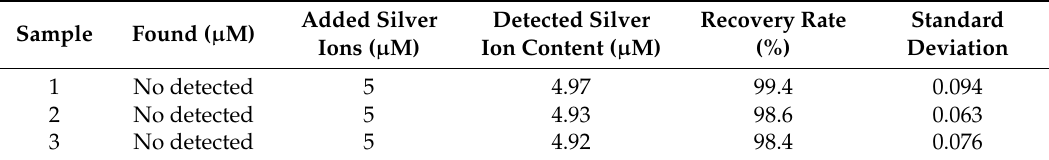
Table 2. Determination results of Ag + in the environmental samples by fluorescent method using QCy (2.5 µ M).